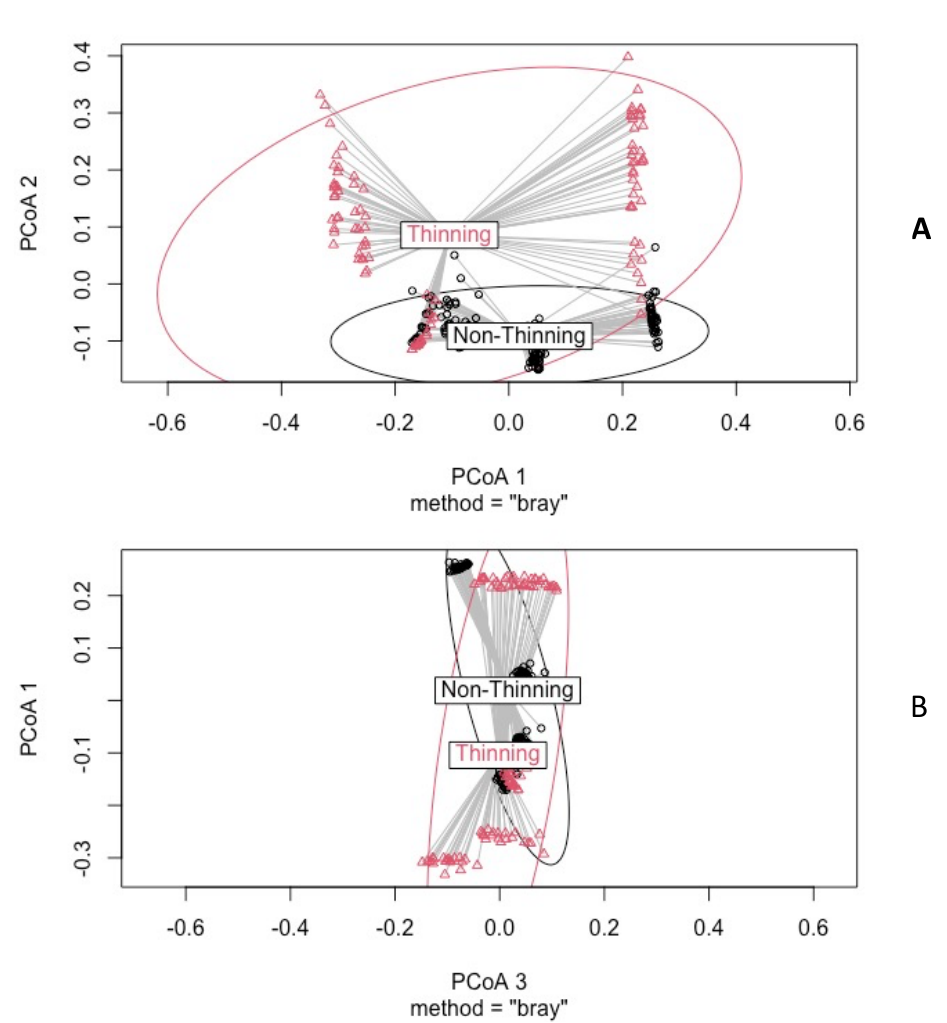
Figure 7. Plot of the groups and distances to centroids based on PCoA1 and PCoA2 ( A ) and based on PCoA2 and PCoA1 ( B ) between teak management.